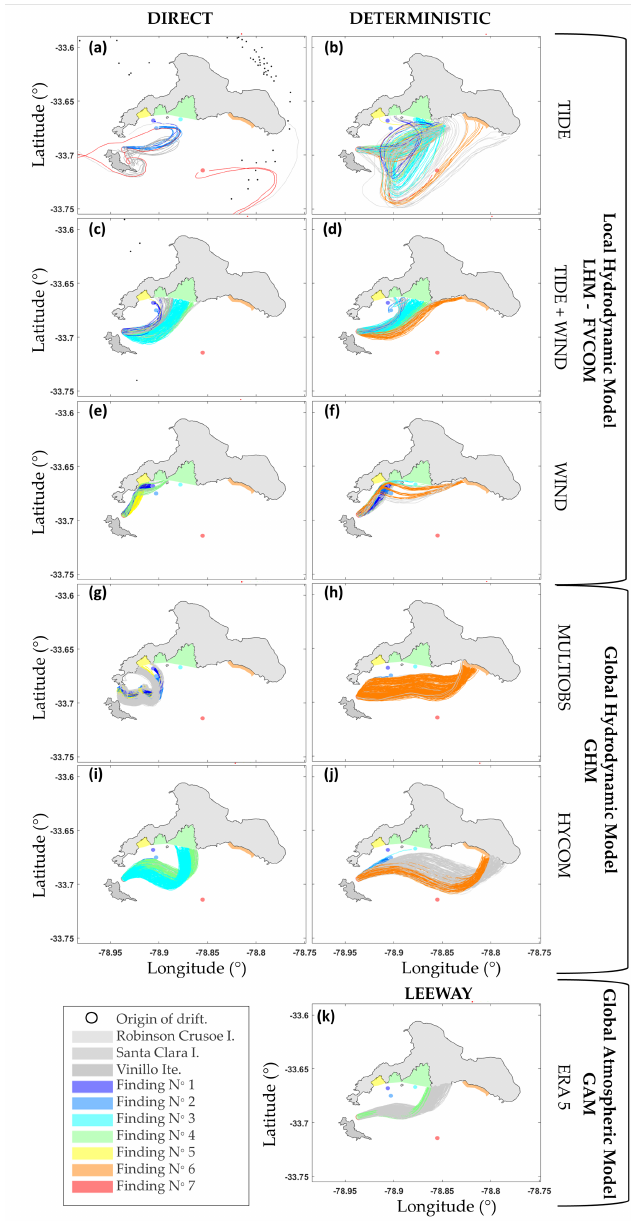
Figure 15. Particle trajectories between 2 and 8 September 2011 using the LHM, GHM, and LEEWAY methods. ( a – f ) LHM method, ( g – j ) GHM method, ( k ) LEEWAY method. Colored lines